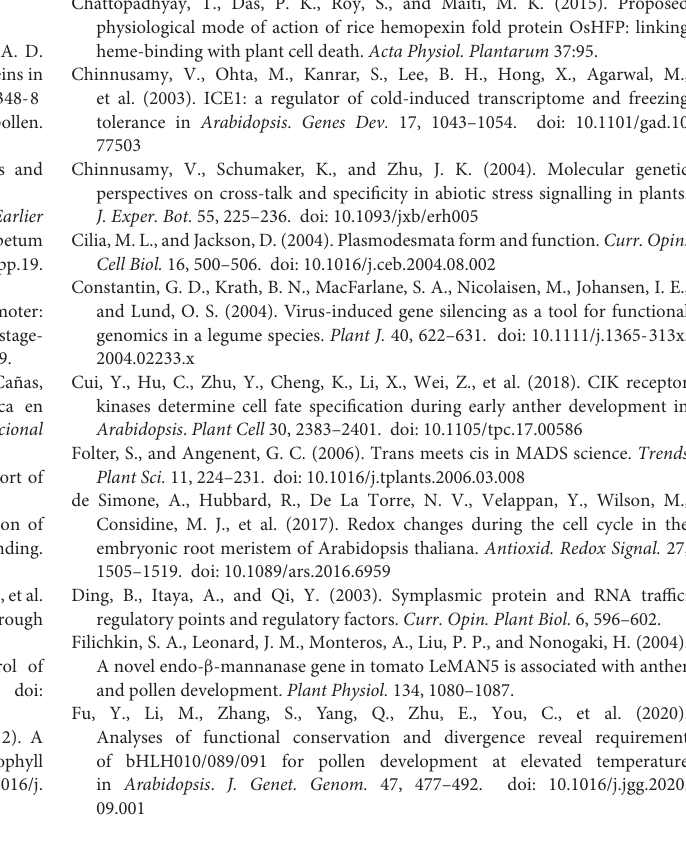
Supplementary Figure 1 | Comparative cross-sections of WT and 35S: PsEND1 Arabidopsis thaliana flowers stained with toluidine blue. (A) Wild type; (B,C) 35S: PsEND1. At the first stages of development, we do not observe differences between anthers in (A,B) , while at the stage of meiocytes (C) most of the anthers have collapsed. After this stage, the pollen mother cells and the tapetum degenerate. Supplementary Figure 2 | PsEND1 sequence and predicted 3D structure showing the heme binding sites. (A) PsEND1 sequence, the hemopexin motifs are highlighted in blue boxes. (B) Predicted PsEND1 3D structure. Cyan: Hemopexin domain at position 4–55; Pink: Hemopexin domain at position 62–112; Orange: Hemopexin domain at position 118–165; Green: Hemopexin domain at position 171–222. (C) Heme binding motifs predicted by the software HeMoQuest. (D) PsEND1 3D model showing the localization of eight heme binding motifs predicted by the software HeMoQuest. The predicted heme binding sites are represented by spheres of different